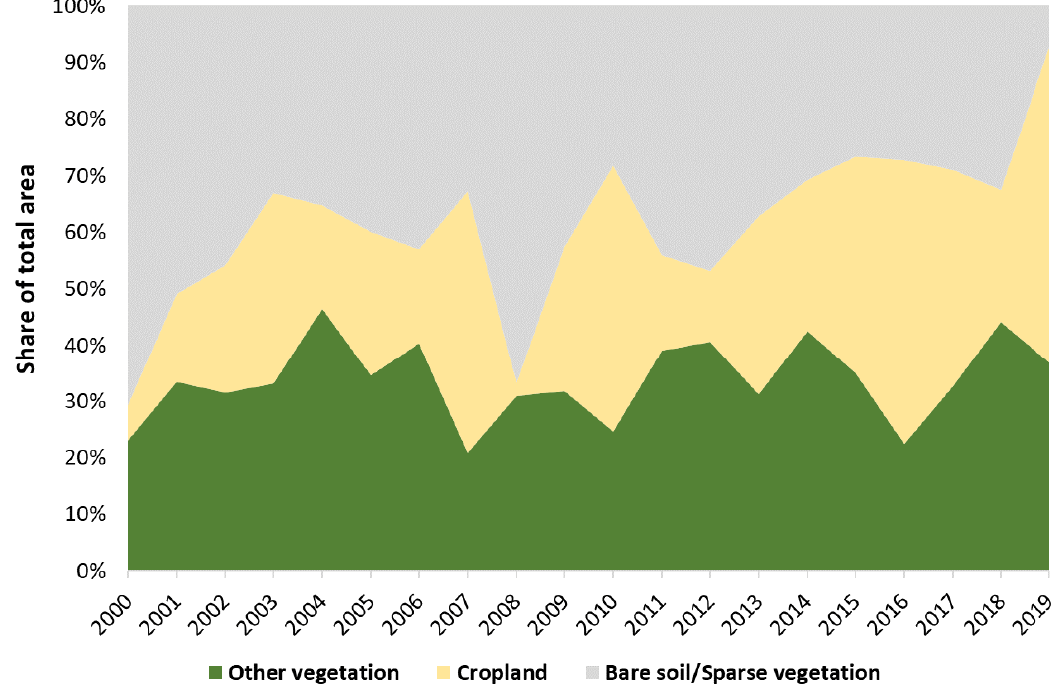
Figure 2. Time series of the proportion of LULC classes in KR-I between 2000 and 2019. Note that single-cropped and double-cropped cropland were merged into one cropland class, which largely consists of single-cropped cropland (see Section 4.1).